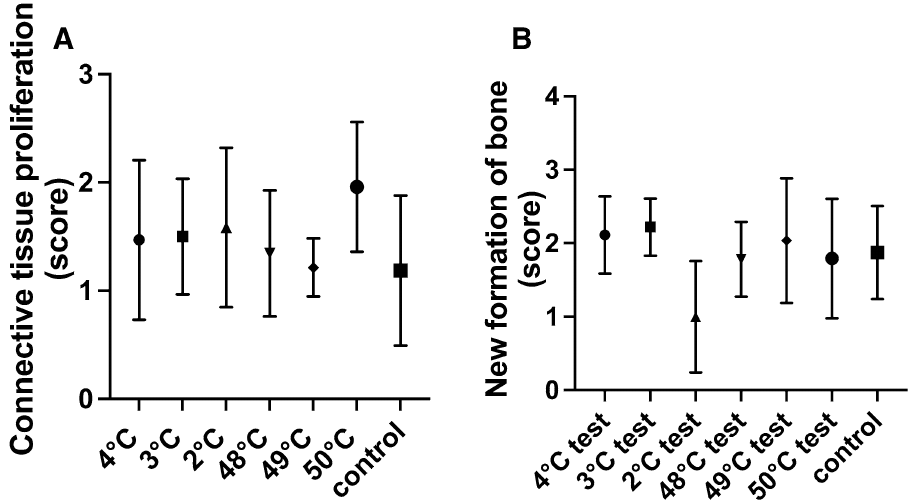
Figure 5. ( A ) The proliferation of connective tissue was evaluated with a score (0 = to 3 = severe amount). ( B ) The new formation of bone after 7 days was measured with a score (0 = to 3 = severe